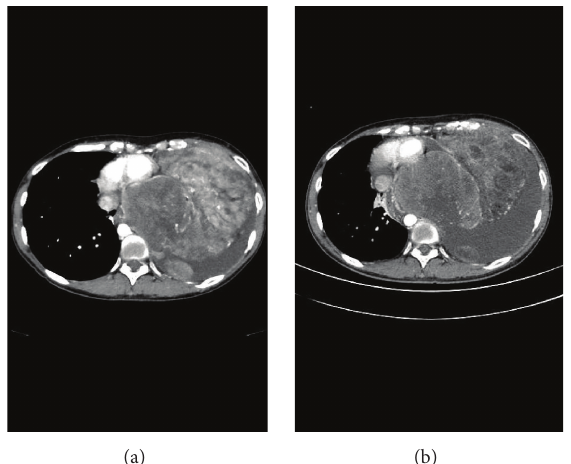
Figure 4: (a) Chest contrast-enhanced computed tomography (CT) before treatment showing a bulky mass in the left chest; pleural dissemination is seen. (b) Chest contrast-enhanced CT after 2 cycles of chemotherapy with doxorubicin showing reduction of the